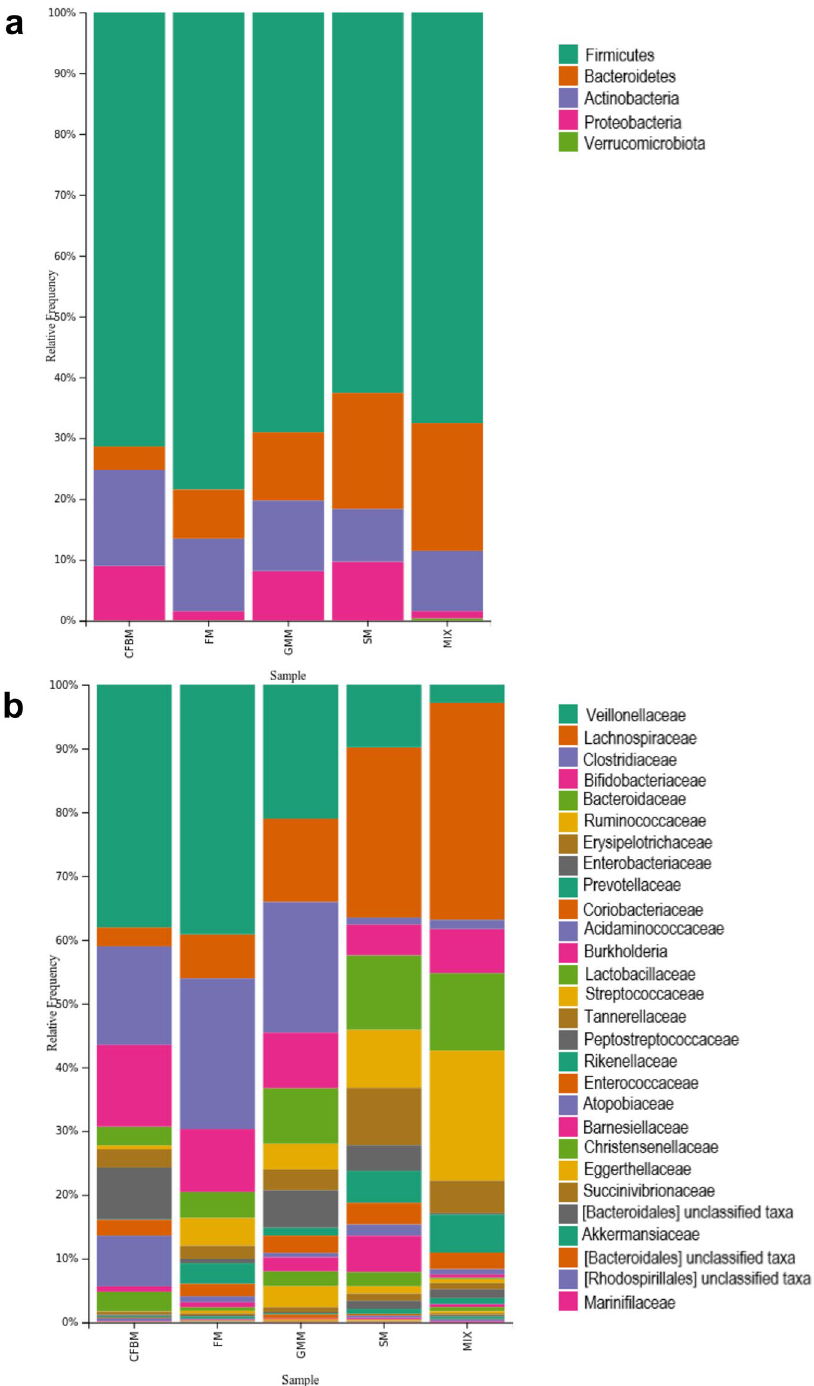
Figure 3. Taxonomic composition of GM communities is presented as the mean of 6 replicates at phylum ( a ) and family ( b ) level after 24 h of cultivation in four different media: CFBM, FM, GMM, and SM compared to the non-cultured MIX inoculum (n = 6). Samples represent viable bacteria after PMA